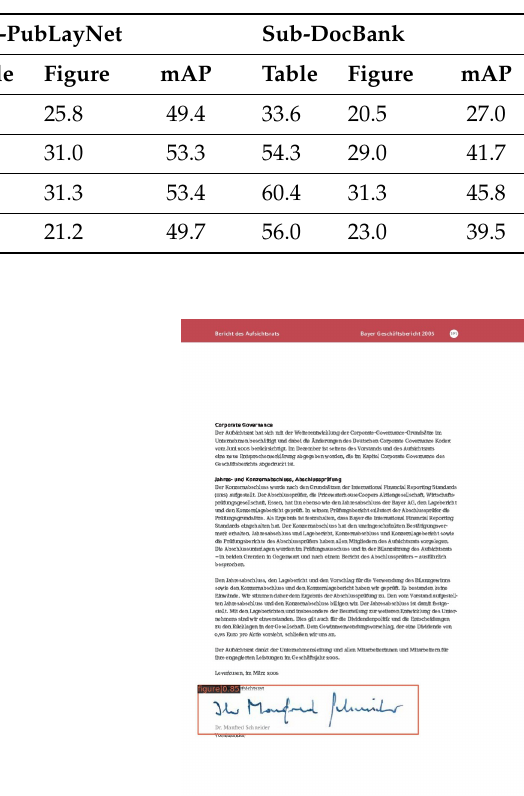
Table 15. The table represents the mAP@(0.5:0.95) of sub-IIIT-AR-13K, sub-PubLayNet and sub- DocBank validation datasets on a sub-IIIT-AR-13K trained model.